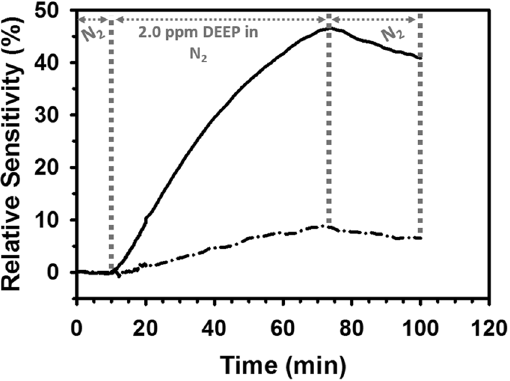
Figure 5. Typical sensing behavior of the proof-of-concept SWCNT-based sensors with dense Ag IDEs (dash- dot line) and with porous Au IDEs (solid line) upon exposure to 2.0 ppm DEEP